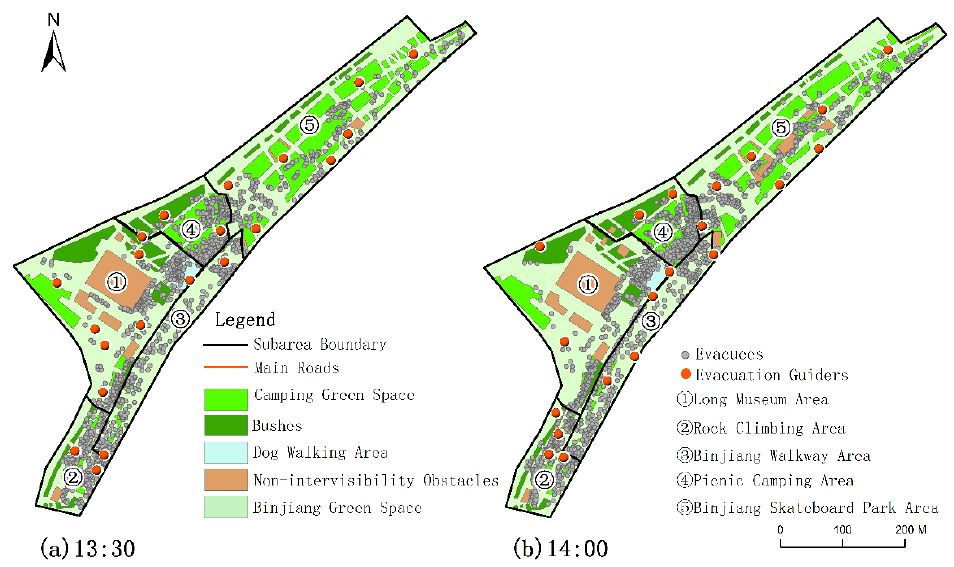
Figure 11. Spatial distribution of evacuees and spatial allocation of evacuation guiders at 13:30 and 14:00 on 5 May 2021.